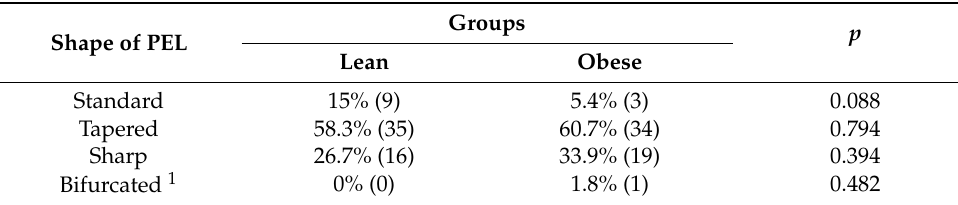
Table 1. Shapes of PELs.